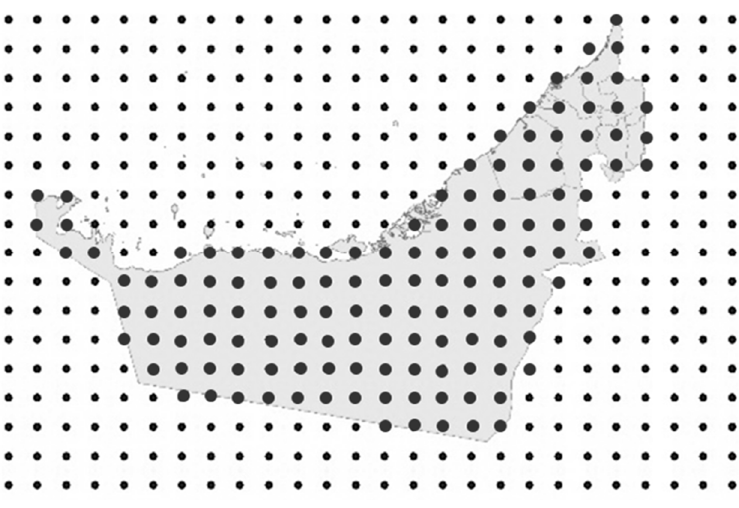
Figure 3. Study area overlaid with the Tropical Rainfall Measuring Mission (TRMM) grid.